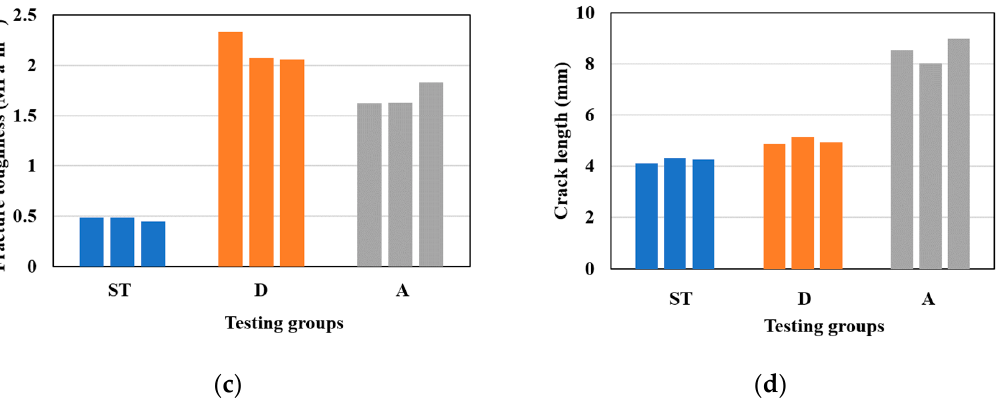
Figure 13. Fracture property parameters calculated from three-point bending tests: ( a ) tensile strength; ( b ) elastic-bending modulus; ( c ) fracture toughness; and ( d ) crack length.